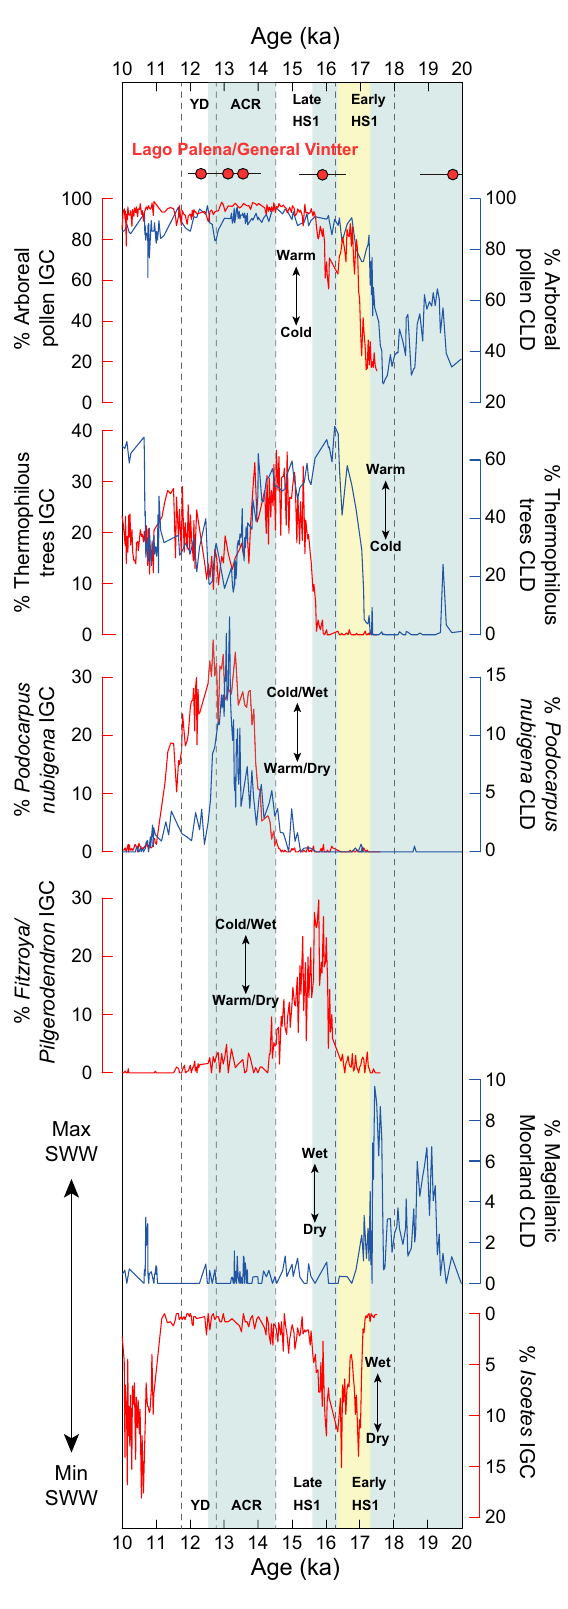
Figure 2. Glacier chronology of the Lago Palena/General Vintter basin and selected species from Canal de la Puntilla and Huelmo mire from the Chilean Lake District (CLD) 12 and Lago Lepué pollen record from Isla Grande de Chiloé (IGC) 40 . Blue bars highlight pollen-based cold/wet intervals and yellow bars denote pollen- based warm/dry periods within